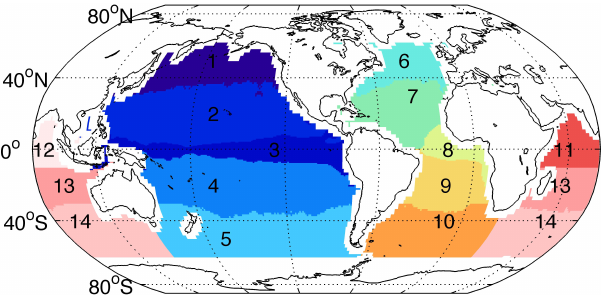
Fig. 1. Map of the 14 ocean biomes used in the analysis (1) High- latitude North Pacific, (2) Oligotrophic North Pacific, (3) Equatorial Pacific, (4) Oligotrophic South Pacific, (5) Southern Ocean Pacific, (6) High-latitude North Atlantic, (7) Oligotrophic North Atlantic, (8) Equatorial Atlantic, (9) Oligotrophic South Atlantic, (10) South- ern Ocean Atlantic, 11) Arabian Sea, (12) Bay of Bengal, (13) Olig- otrophic Indian, (14) Southern Ocean